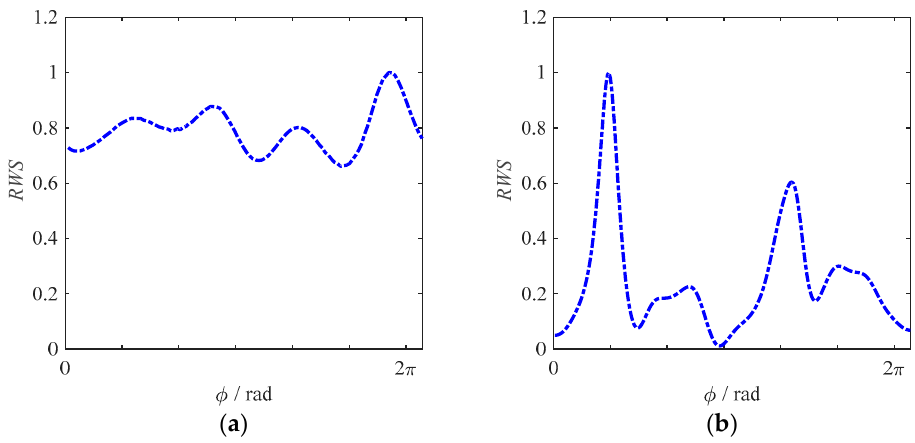
Figure 7. Comparison of RWS: ( a ) no crack, ( b ) with crack.